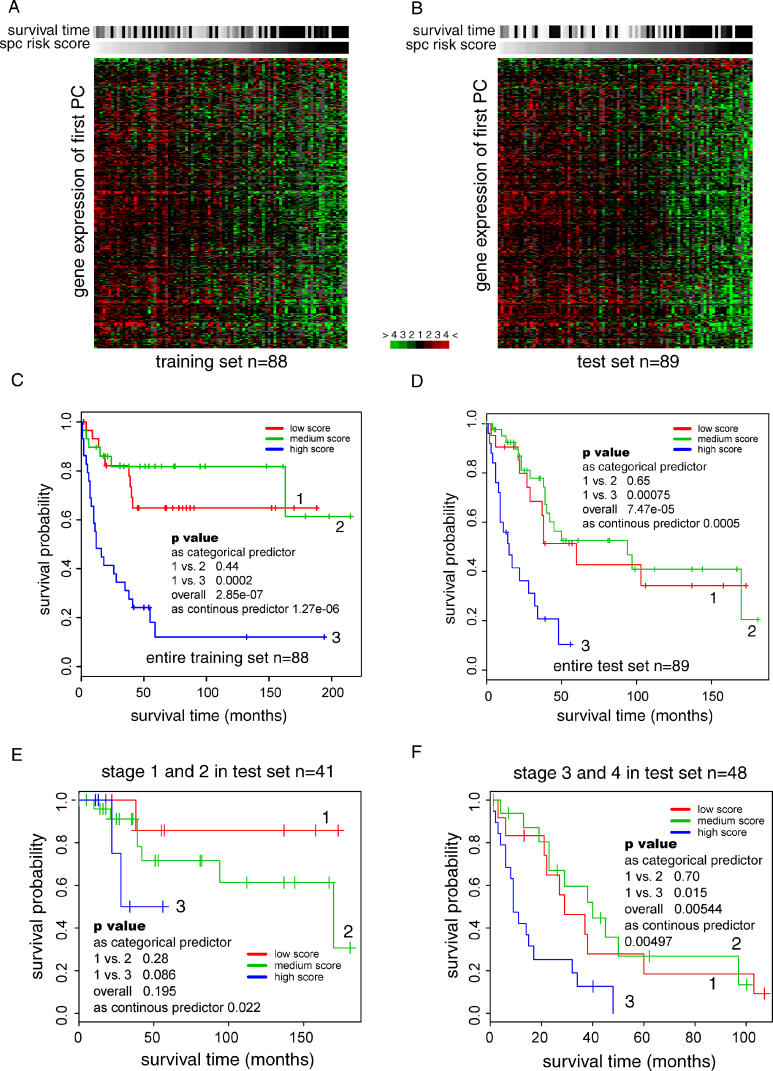
Outcome Prediction Using the SPC Risk Score(A) Overview of the gene expression patterns of the 259 prognostic genes in the training set, with their SPC risk scores arranged in ascending order and the survival time in descending order. Each row represents a single gene, and each column a patient sample. The degree of color saturation corresponds to the ratio of gene expression in each sample compared to the mean expression across all samples.(B) Gene expression profiles of the 259 prognostic genes in the test set.(C) Kaplan-Meier estimates of disease-specific survival in low-, intermediate-, and high-risk groups of patients in the training set defined by the tertiles of SPC risk scores.(D) Kaplan-Meier estimates of disease-specific survival of low, intermediate and high-risk groups of patients in the test set defined based on the tertiles of the SPC risk scores of the training set.(E) Kaplan-Meier estimates of disease-specific survival in stage group I and II patients in the test set.(F) Kaplan-Meier estimates of disease-specific survival in stage III and IV patients in the test set.